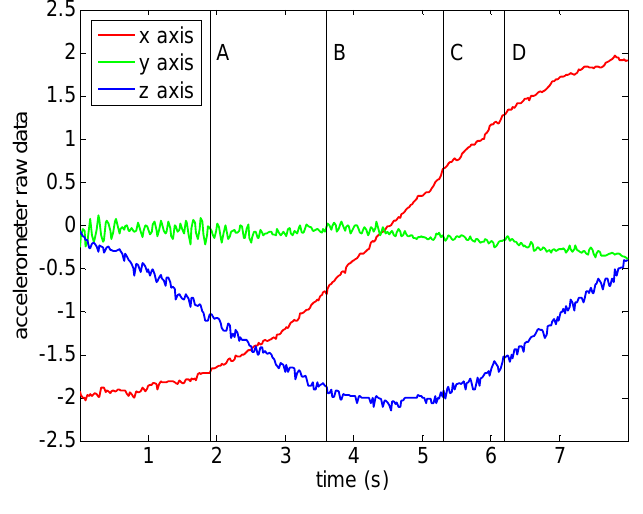
Figure 7. Acceleration data obtained when raising the forearm. Table 1 show positions A, B, C and